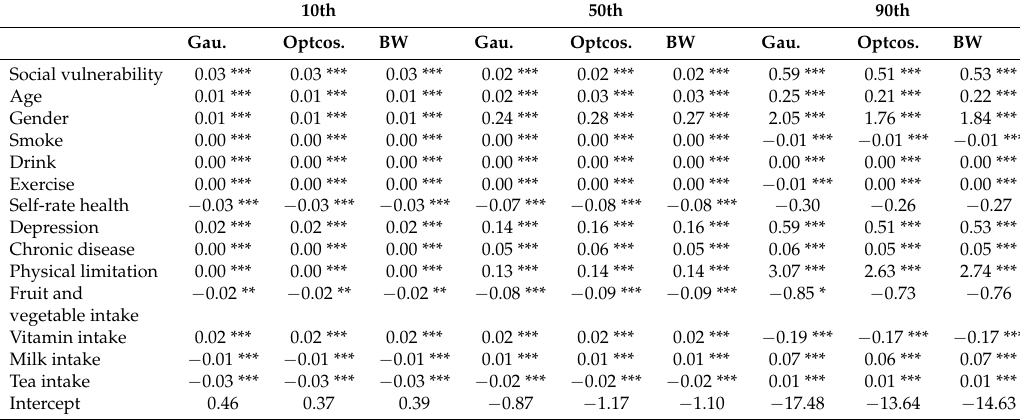
Table 5. Robustness checks: UQR results using different kernel density